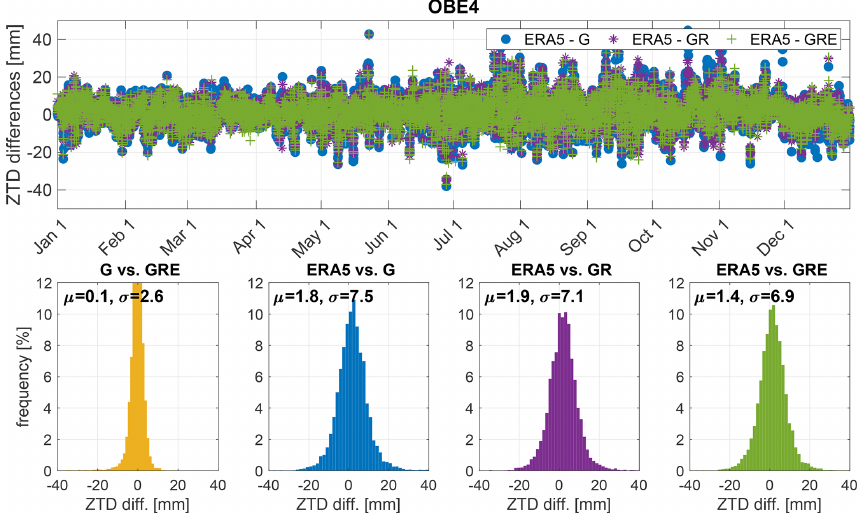
Figure 10. The ZTD difference values for station OBE4 (Oberpfaffenhofen, Germany) between the three GNSS solutions: GPS-only, GR and GRE and ERA5 model (top) and histograms of the differences between the particular solutions and models (bottom). The plots are